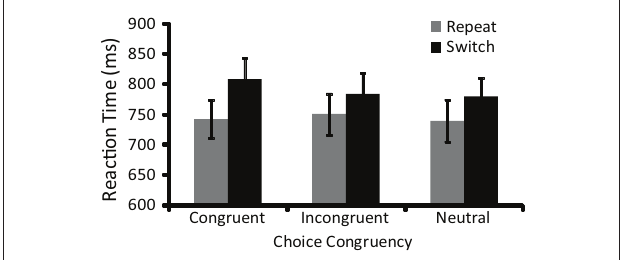
Figure 4 | Switch costs (i.e., incongruent rT–congruent rT) were larger in congruent task choice trials than in either incongruent or neutral task choice trials. Error bars represent 95% confidence